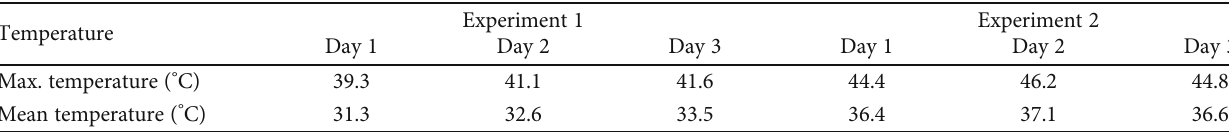
Figure 6: Temperature distribution of PCM plates. Table 6: Characteristic data of mean temperature of external side temperature of phase change board 1, 2, and